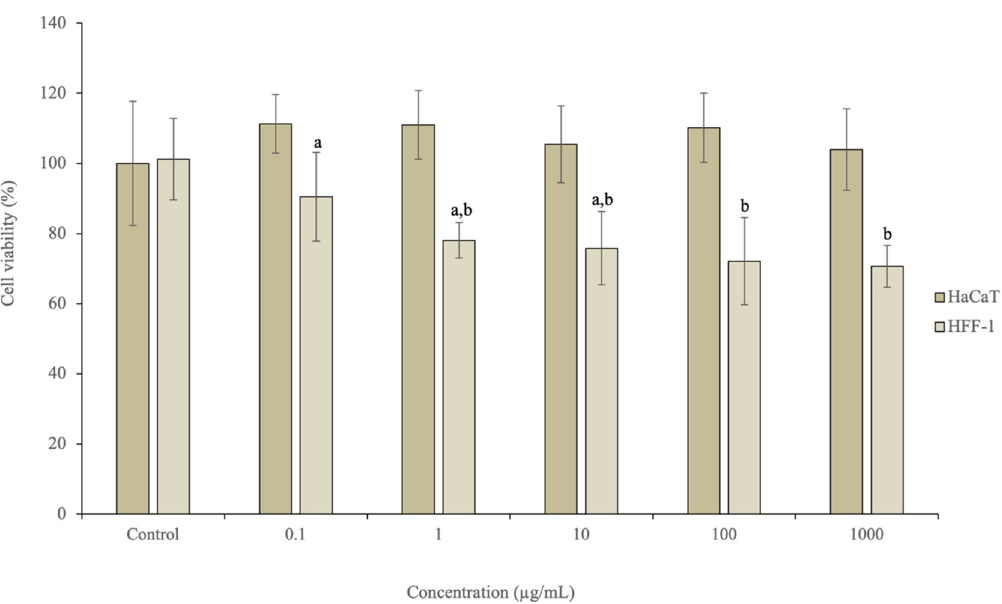
Figure 4. Effects of the optimal extract exposure on the viability of HaCaT and HFF-1 cell lines at different concentrations (0.1–1000 µg/mL), measured by the MTT assay ( n = 3). Different letters (a, b) mean significant differences between the different tested concentrations ( p < 0.05).